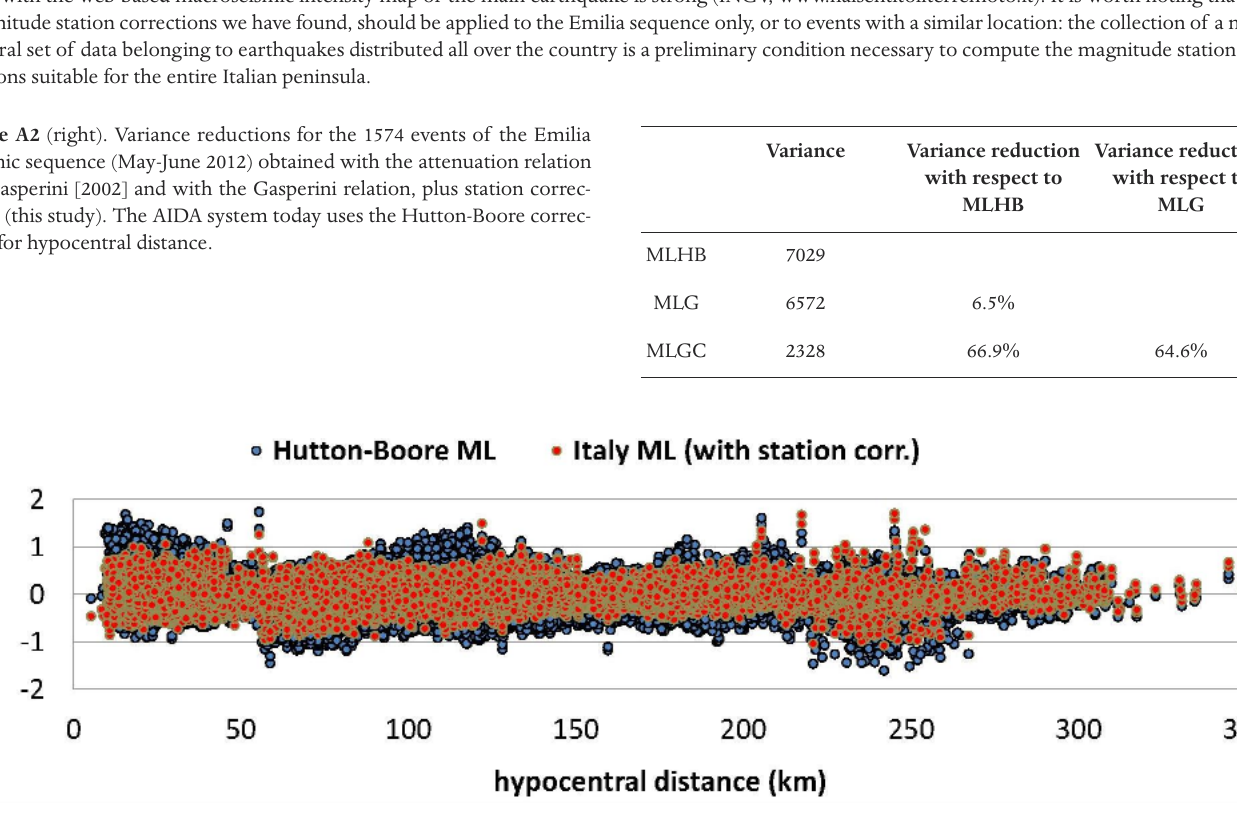
Figure A2. Station magnitude values minus the event magnitudes, computed with the Hutton-Boore relation (blue circles) and with the Gasperini re- lation for Italy and station corrections (red superimposed circles), as a function of the hypocenter-to-station distance. The distribution of these last mag- nitudes shows a reduction in the dispersion of the data at all distances.